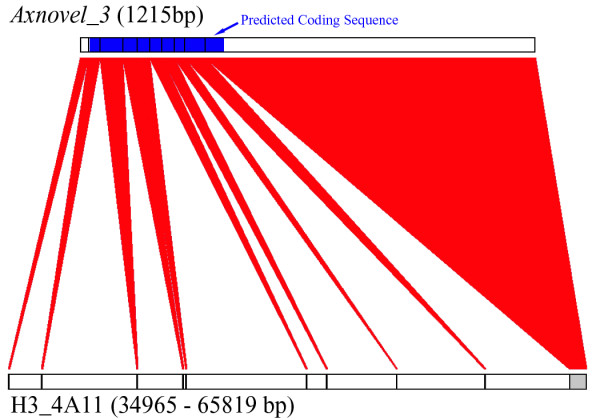
Intron-exon structure of a novel axolotl salamander gene (AxNovel_3) discovered within BAC H3_4A11. Intron/Exon boundaries are represented by vertical black bars. The predicted coding sequence for AxNovel_3 is shaded in blue. Red figures join the relative locations of sequences in the transcript and genomic sequence.